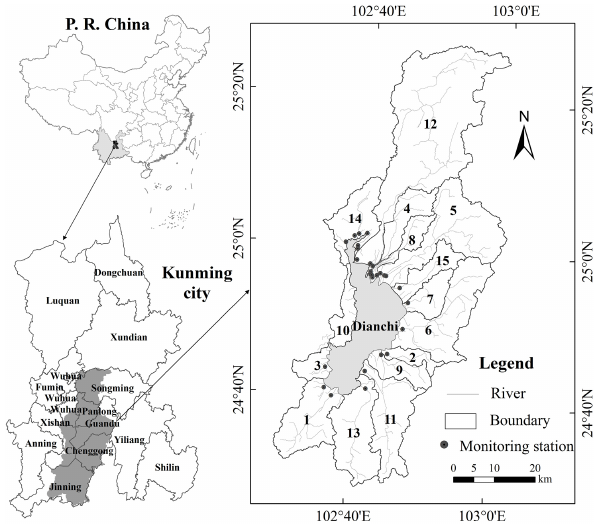
Figure 1. Location of the Lake Dianchi basin and the boundaries of its 15 catchments. The Lake Dianchi basin lies in the south of Kunming, the capital of Yunnan Province,